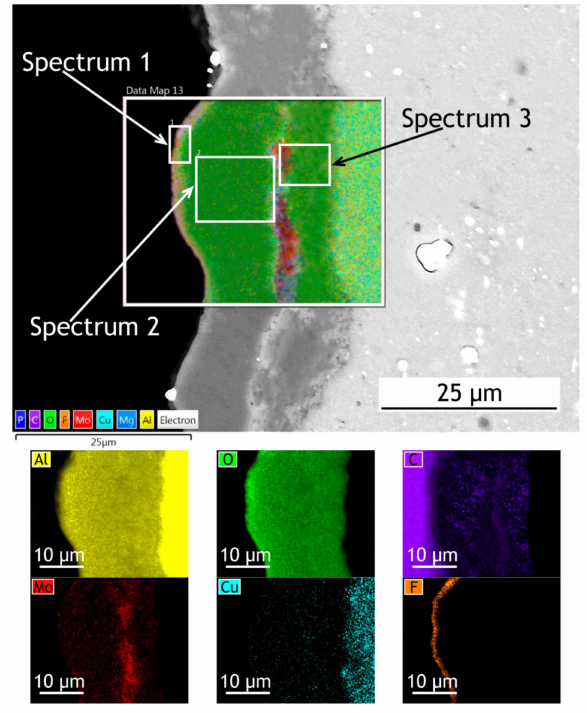
Figure 5. SEM image and EDX maps of the CC